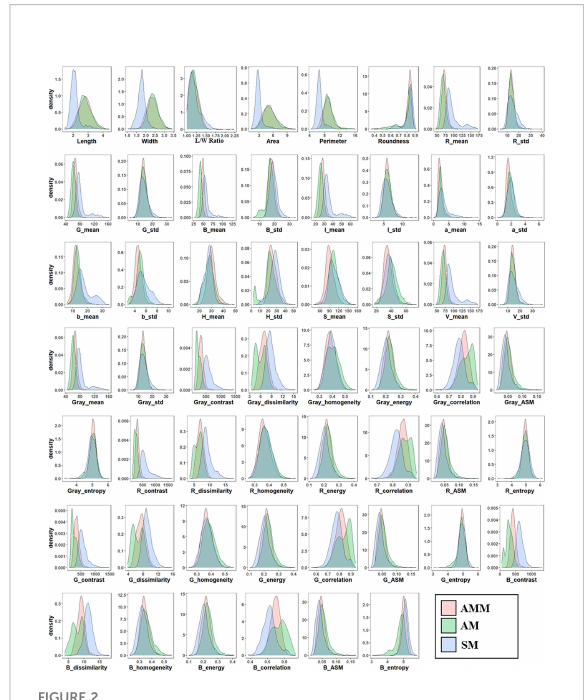
FIGURE 2 Probability density distribution of phenotypic features of AMM, AM, and SM